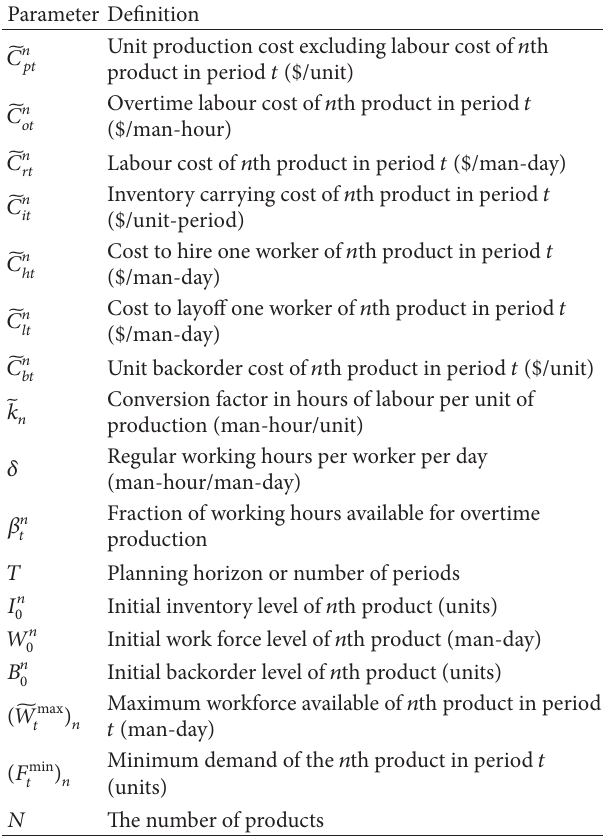
Table 2: Notation for parameters of the fuzzy APP